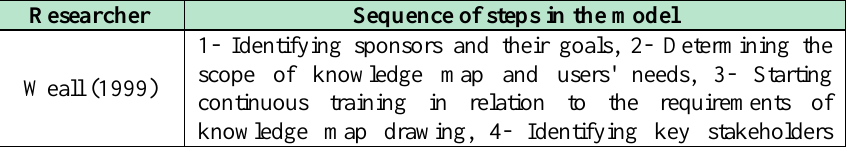
Table 4: Models and processes of knowledge